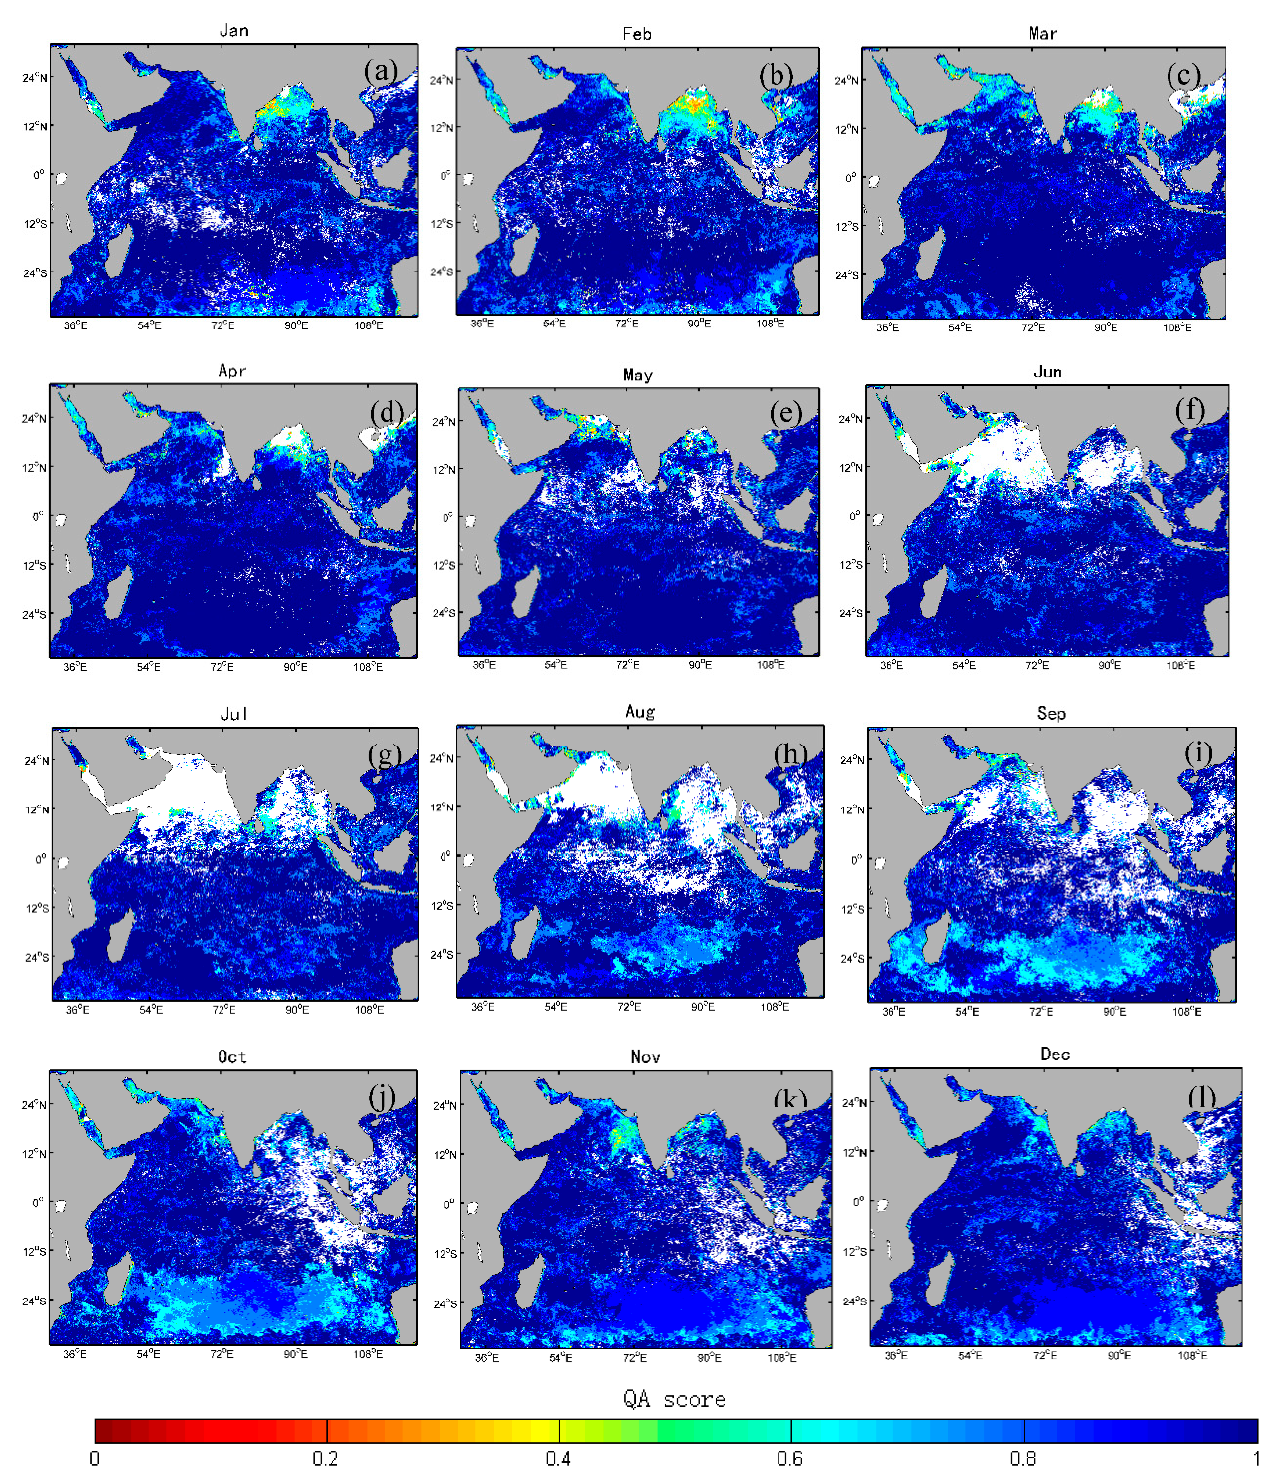
Figure 3. Monthly QA scores of MODIS–Aqua level 3 R rs ( λ ) products from January ( a ) to December ( l ) in 2016 in the IO. The white color represents invalid pixels.